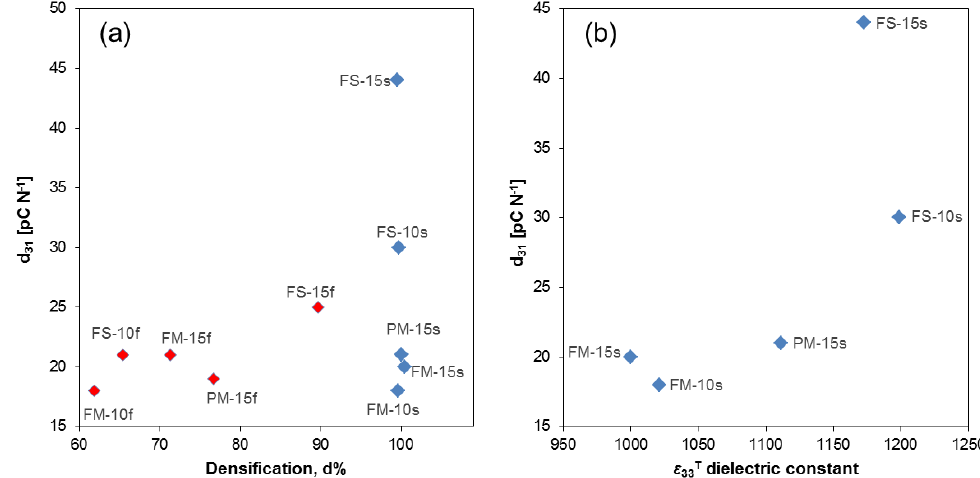
Figure 5. ( a ) Permittivity as a function of PZT average grain size. ( b ) Permittivity versus Sauter’s diameter of the CFO particles.